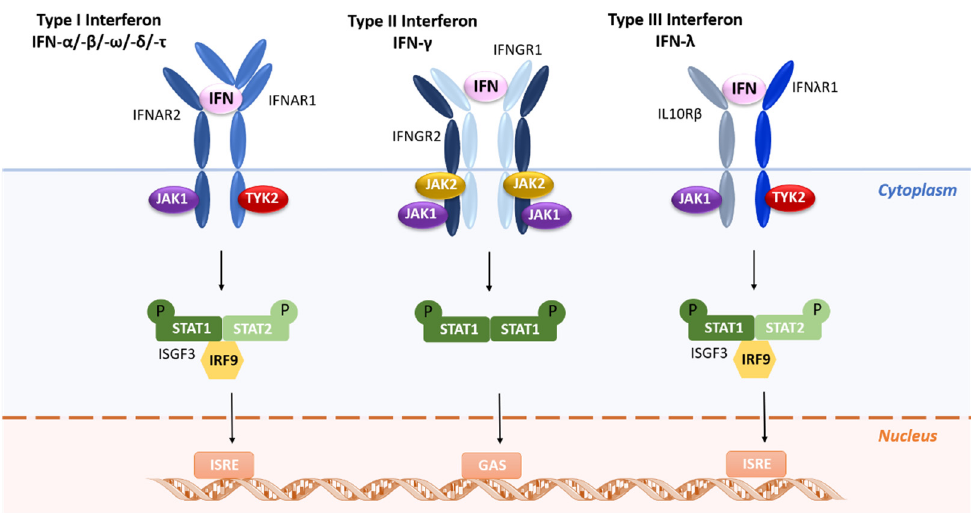
Figure 1. Receptor activation or ligand-receptor complex assembled by type I, type II, or type III interferons.